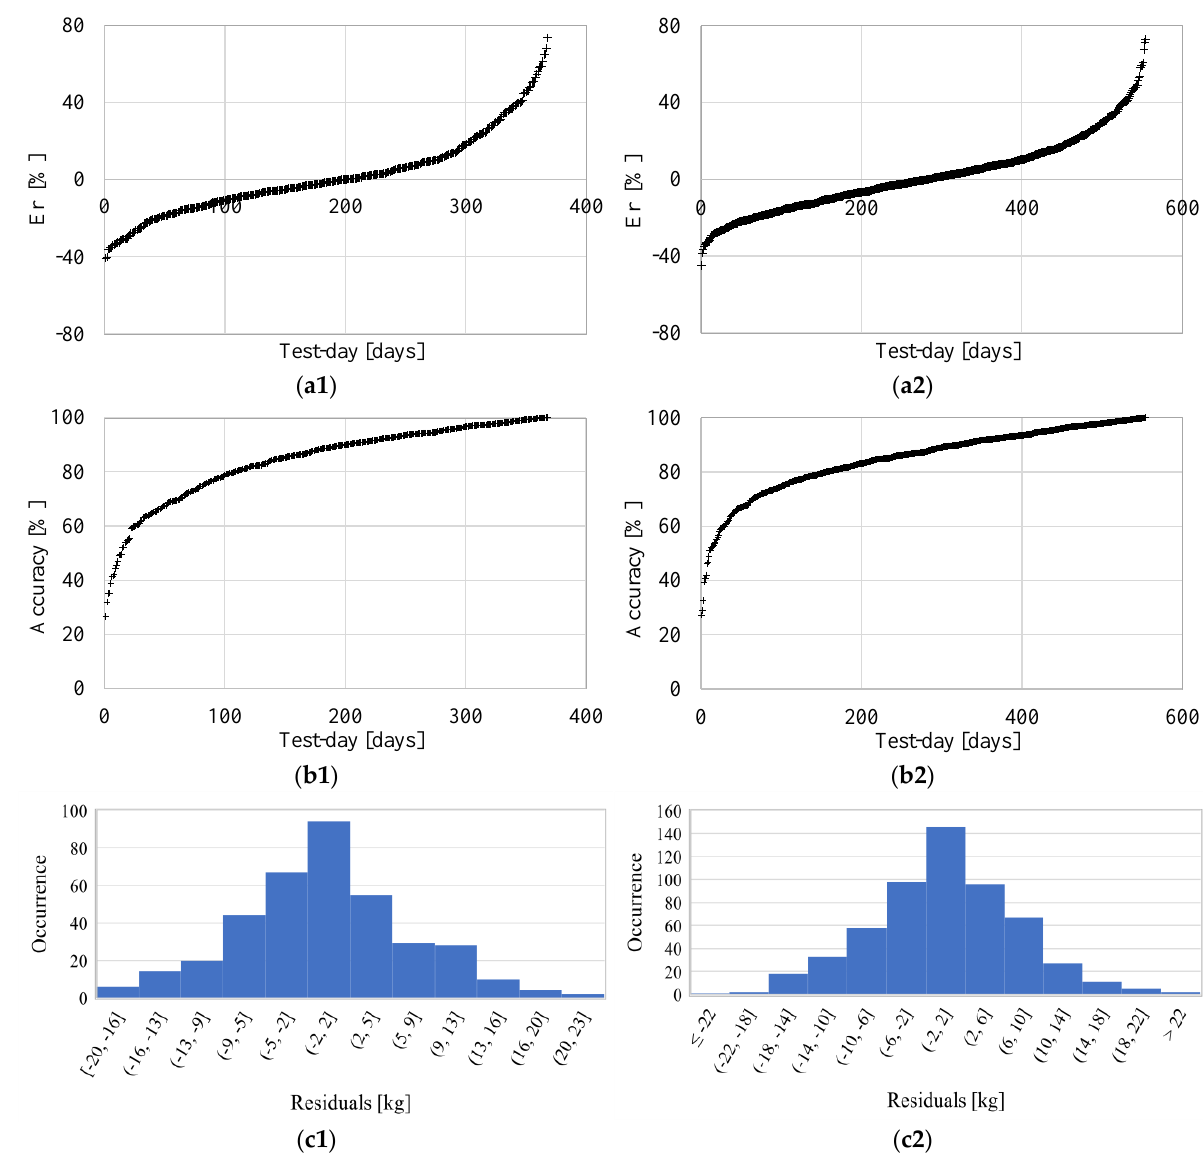
Figure 6. Main results obtained for scenario A for two representative cows where ( 1 ) represents animal #226 and ( 2 ) animal #243. ( a ) Relative error Er of the daily yield in ascending order; ( b ) accuracies of the daily yield predictions in ascending order; ( c ) histogram representation of the residuals of the predictions.